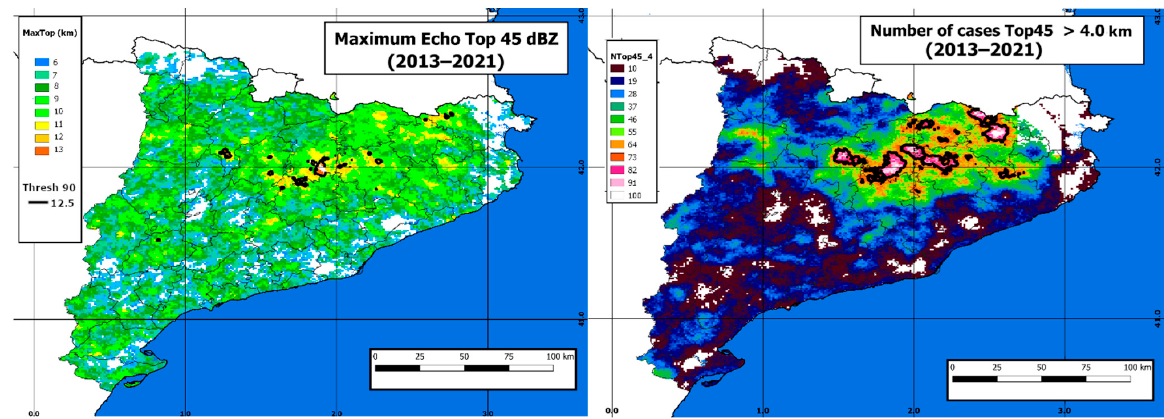
Figure 5. Same as Figure 4, for the TOP45, with a height threshold of 4 km. Areas with white color in left panel indicate that maximum TOP45 did not exceed 6 km at any time during the period of study.